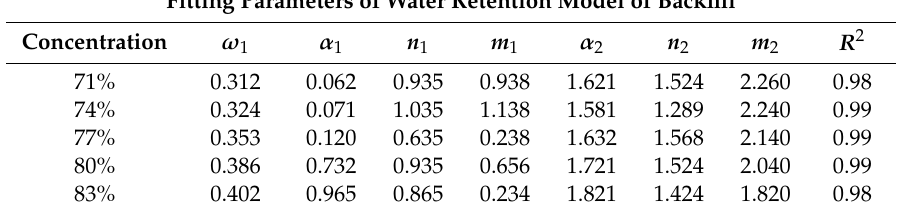
Table 5. Analysis of the fitting parameters of the water retention model of backfills at a cement–tailings ratio of 1:8 with di ff erent